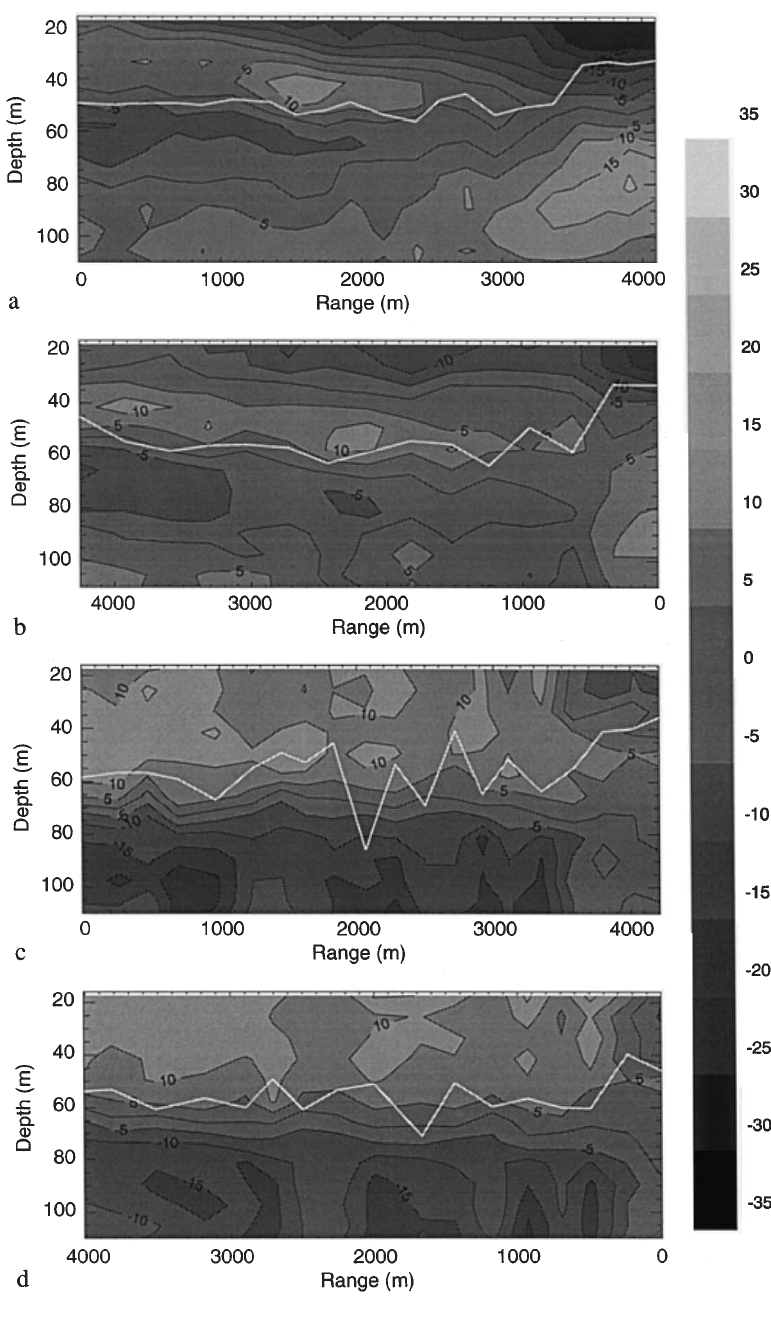
Fig. 8a–d. Internal eastward currents from ADCP for the four surveys of Fig. 5, shown as a function of range. Here the depth averaged ADCP values have been removed from the original signal. Overplotted is the 12 (cid:176) C isotherm from the thermistor chain data sub-sampled to the ADCP resolution. Velocities in cm s )